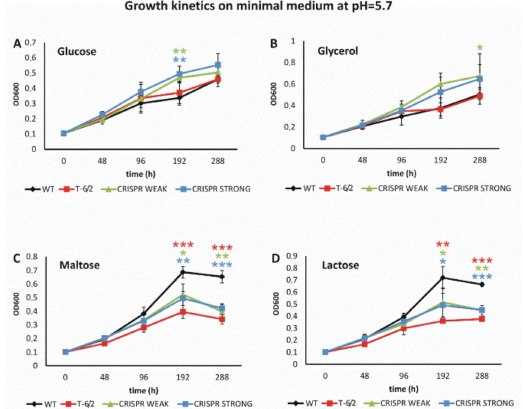
Figure 4. The growth kinetics of Mtb and ppe51 mutants on minimal medium at pH = 5.7. Growth kinetics of the wild-type (black) strain and the T-6 / 2 (red), PPE51 CRISPR weak (green) and PPE51 CRISPR strong (blue) mutants of M. tuberculosis in minimal medium containing glucose ( A ), glycerol ( B ), maltose ( C ) or lactose ( D ), at pH = 5.7. The growth kinetics were evaluated by measuring the absorbance at 600nm at the indicated time points. The displayed values are the means ± standard errors of at least three independent experiments. Statistical significance: one, two and three stars denote p -values ≤ 0.05, ≤ 0.01 and ≤ 0.001, respectively (Student’s t -test). Statistical significance between the wild-type strain and the T-6 / 2 (red star), PPE51 CRISPR weak (green star) and PPE51 CRISPR strong (blue star) mutants was analyzed at 192 and 288 h of growth.